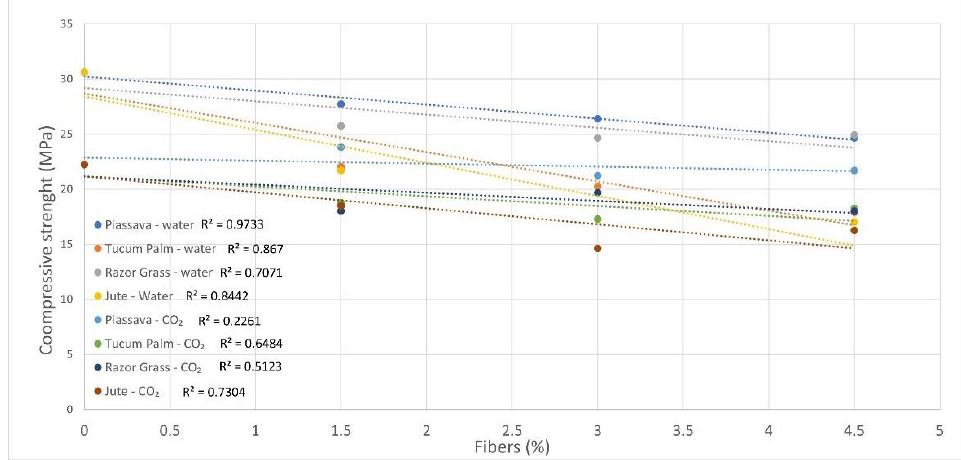
Figure 8. Correlation between compressive strength (28 days) versus fibers’ content. R 2 values are presented on the graphs.